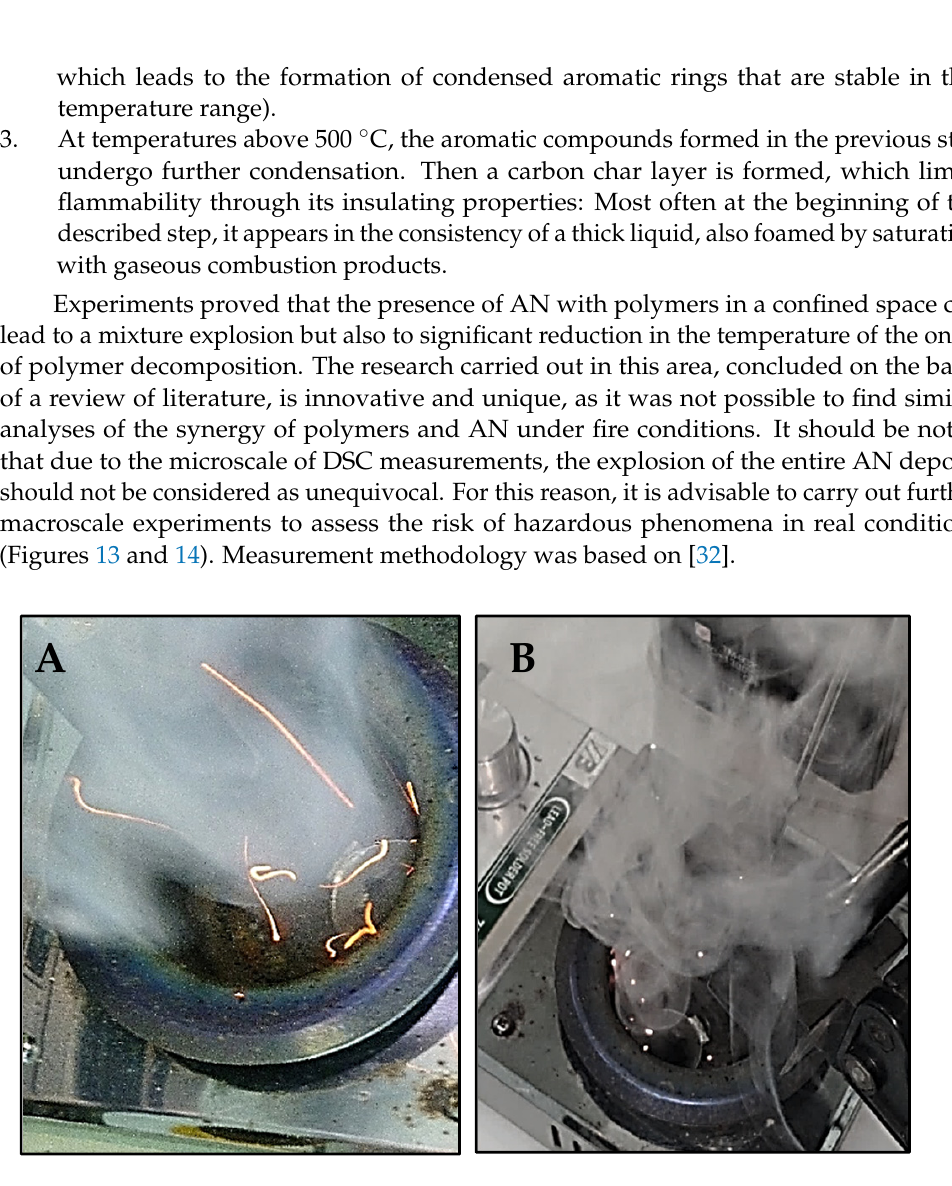
Figure 13. Furnace with an open nickel-measuring crucible gradually heated (10 °C/min). The compacted samples of 20% uPVC (hard)/AN ( A ) and 10% carbon/AN ( B ) were placed in the crucible.